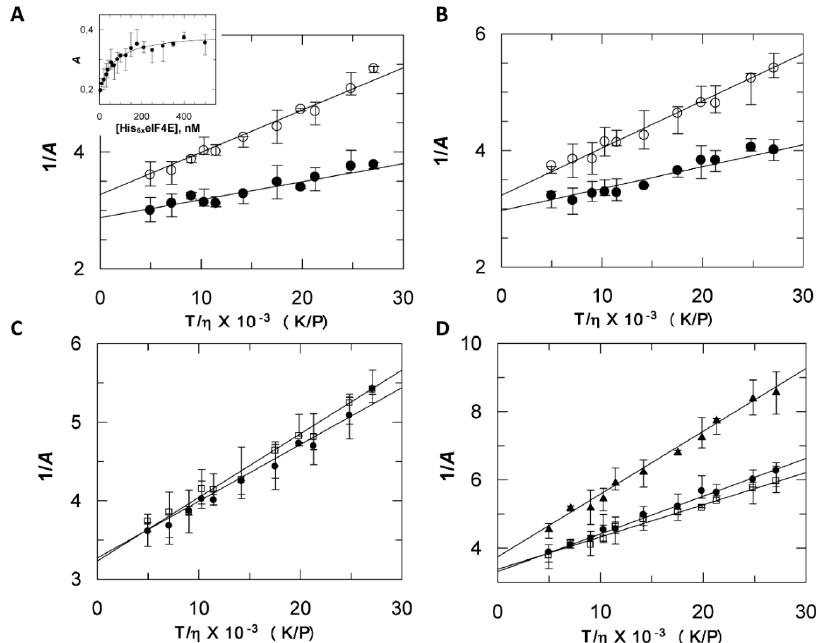
Figure 2. Fluorescence anisotropy of the various molecular forms of eIF4E and VPg. ( A ) The fluorescence anisotropy of His 6 VPg* (300 nM, open circles) and His 6 VPg*-His 6 eIF4E complex (mix of 300 nM His 6 VPg* and 2 µM His 6 eIF4E filled circles) was recorded as a function of the viscosity increase at 25 °C. The reciprocal of the emitted light anisotropy (Perrin’s plot), 1/ A , is plotted as a function of T/ η . V , the apparent molecular volume of the proteins and their complexes and A 0 , the fundamental anisotropy were obtained respectively from the slope and intercept at infinite viscosity. Inset, the fluorescence anisotropy increase upon association of His 6 eIF4E with His 6 VPg* (300 nM). ( B ) Perrin’s plots of untagged VPg* (open circles) and VPg*-eIF4E complex (filled circles) in the same conditions as ( A ). ( C ) Perrin’s plots of His 6 VPg* (open squares), VPg* (filled circles) and D. His 6 eIF4E* (filled circles), eIF4E* (open squared) and eIF4E ∆ 1–46 * (filled triangles). Experimental conditions were the same as in B. All measurements were obtained using VPg from lettuce mosaic virus (LMV) AF199